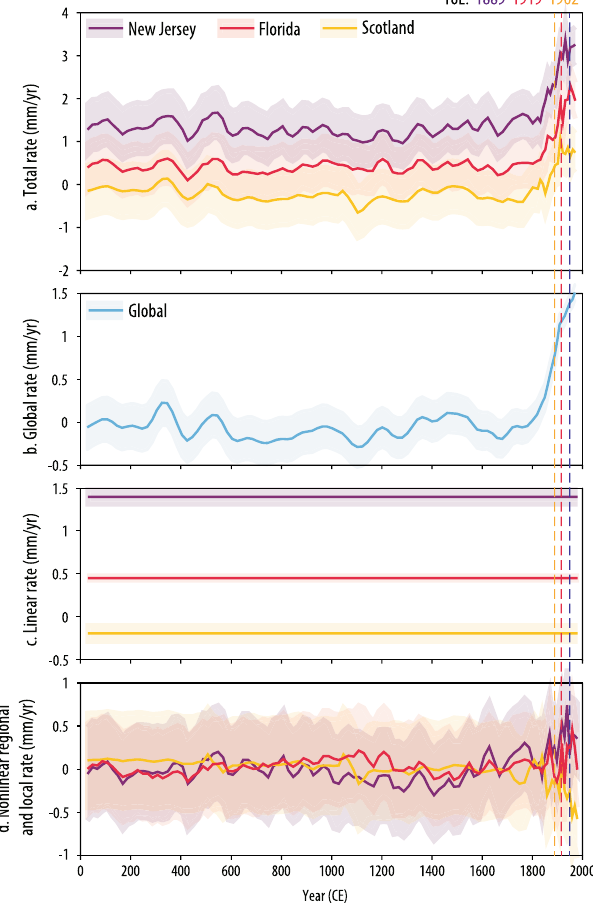
Fig. 3 Spatiotemporal model decomposition for New Jersey, Florida, and Scotland. a Total, b global, c linear, and d regional and local nonlinear rates for three sites (New Jersey, Cheesequake; Florida, Nassau; Scotland, Kyle of Tongue) are shown with the time of emergence for each site. Model predictions are the mean with 1 σ uncertainty. Note variable y